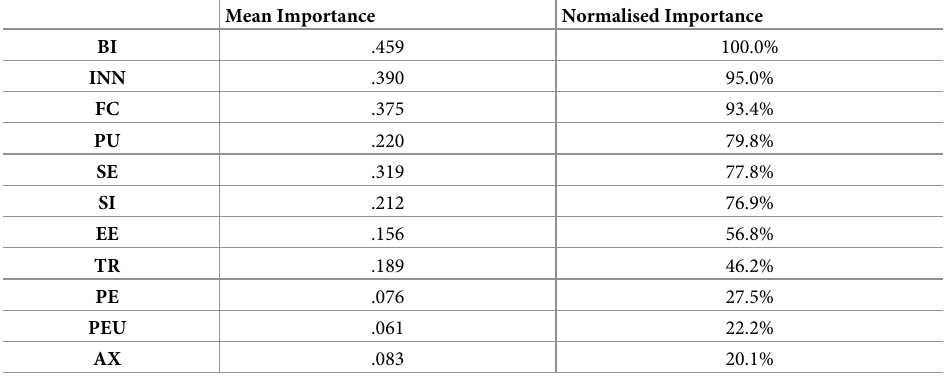
Table 9. Independent variable